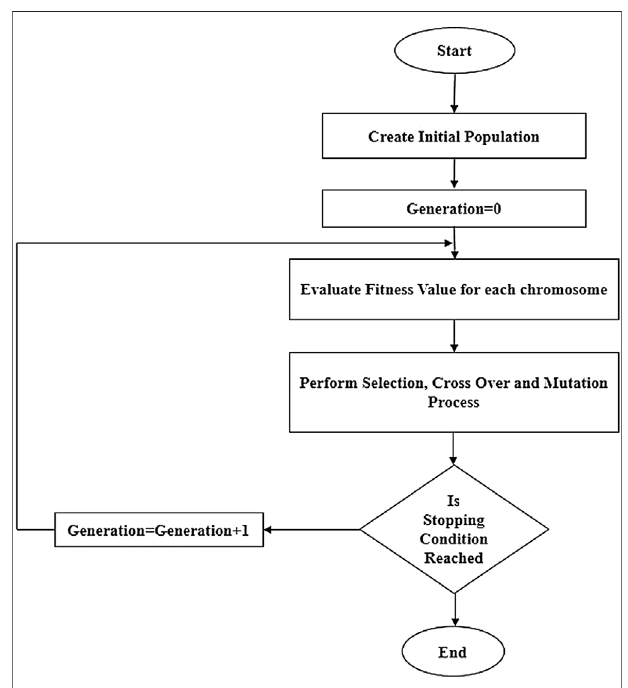
FIGURE 3 | Basic genetic algorithm